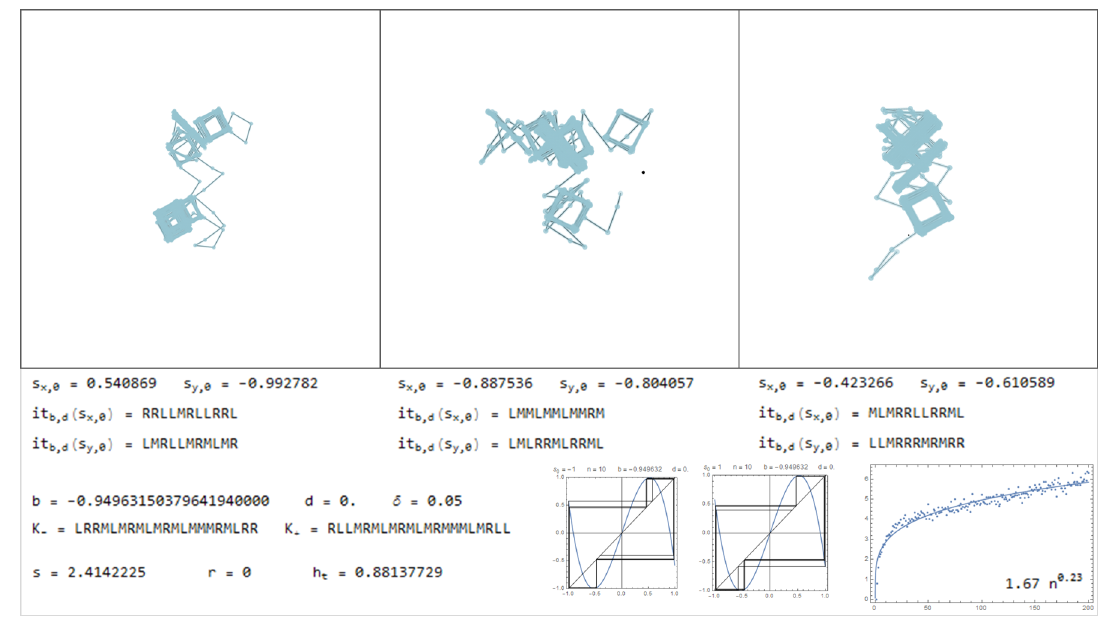
Figure 19. Trajectories produced with b = − 0.9496315 . . . and d =